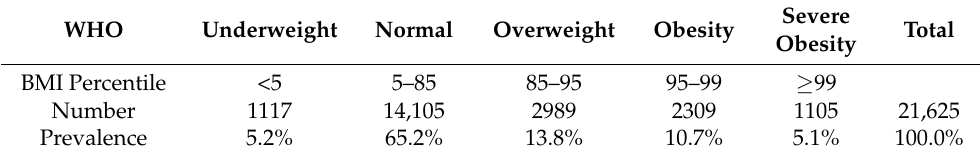
Table 2. Prevalence of underweight, overweight, obesity and severe obesity using WHO percentile.